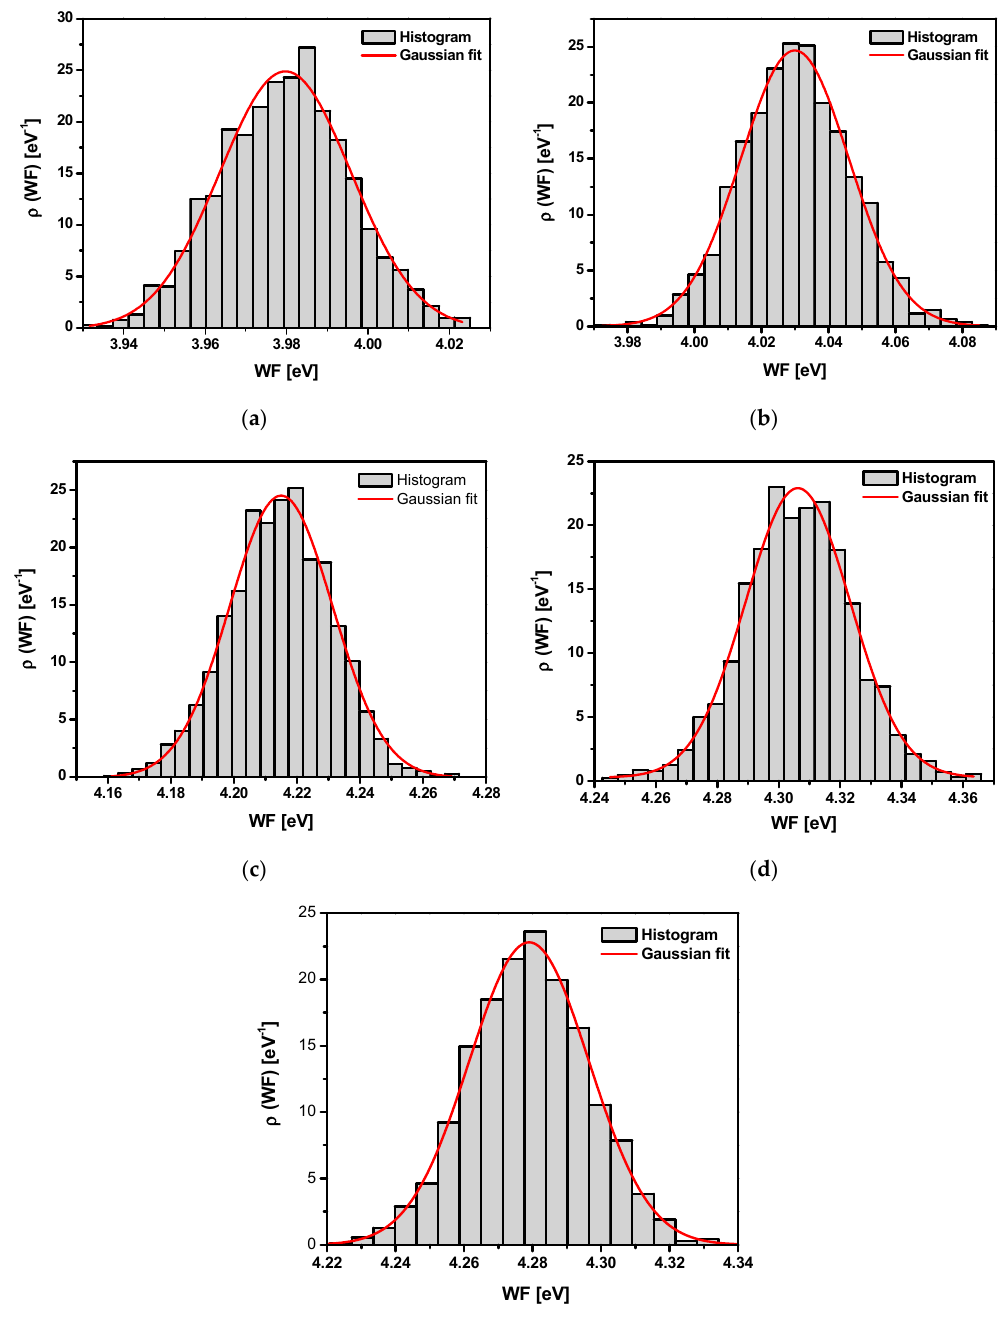
Figure 12. Work function distribution histogram and Gaussian fitting curve corresponding to Figure 11